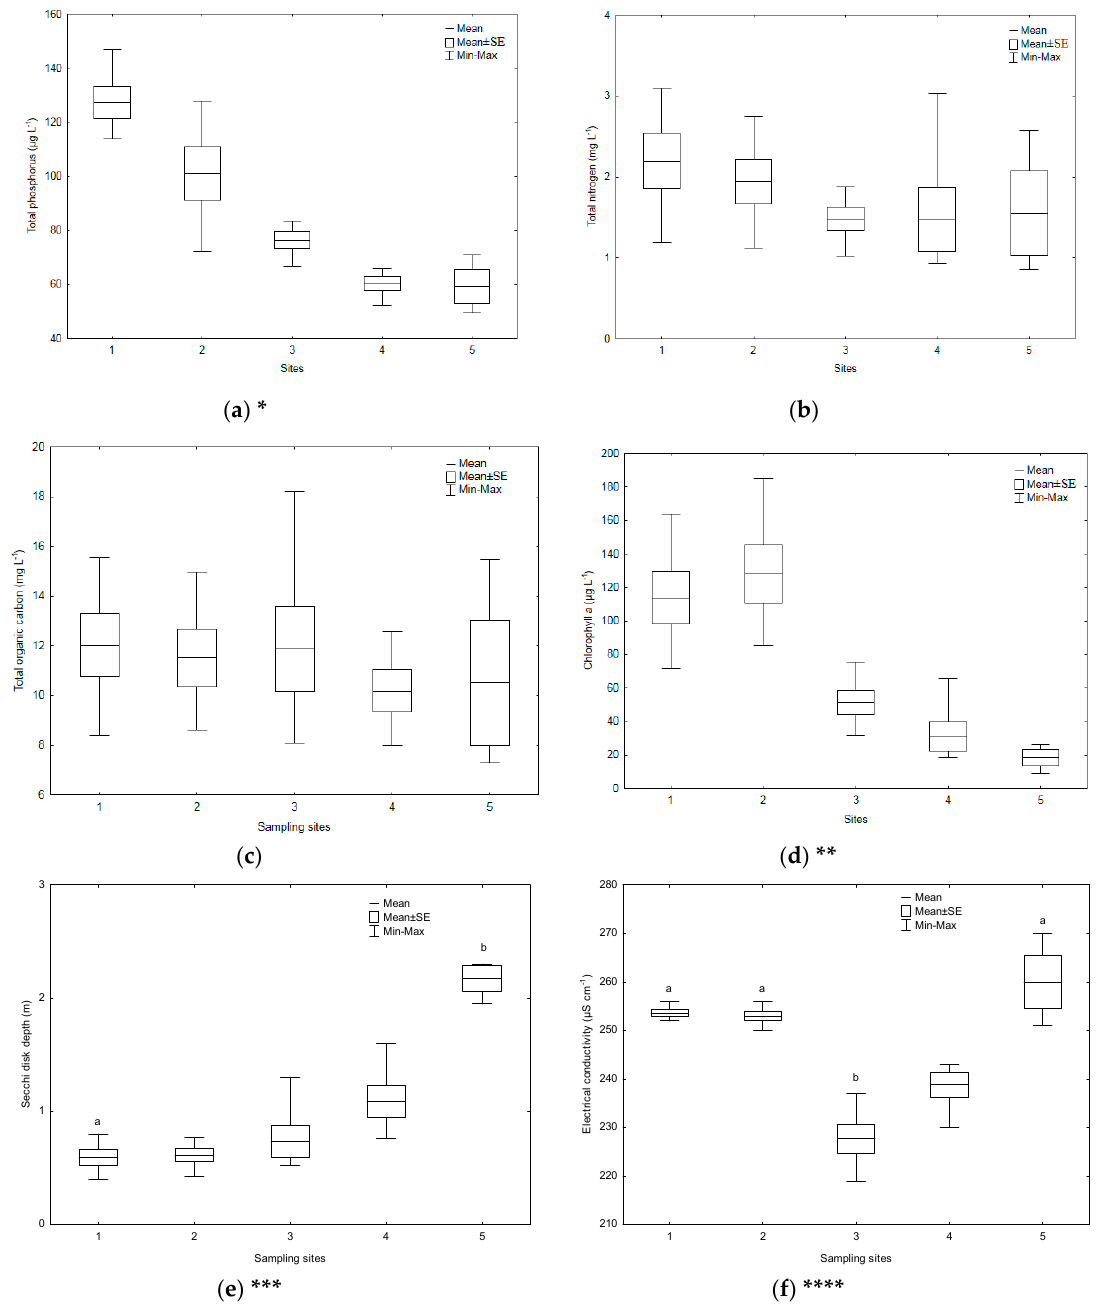
Figure 2. Spatial distribution of the main environmental parameters: total phosphorus ( a ), total nitrogen ( b ), total organic carbon ( c ), chlorophyll a ( d ), Secchi disk depth ( e ) and electrical conductivity ( f ); significant differences between sampling sites: the letters a and b indicate significant differences between sites: * KW-H (4;23) = 18.5918; p = 0.0009; ** KW-H (4;23) = 18.029; p = 0.0012; *** KW-H (4;23) = 13.5351; p = 0.0089; **** KW-H (4;23) = 17.6; p = 0.0015. Table 1. Trophic state index (TSI) and its partial indices based on summer data on chlorophyll a (TSI CHL ), Secchi disk depth (TSI SDD ), total phosphorus (TSI TP ), total nitrogen (TSI TN ) at five sites in Lake Warno ł ty.